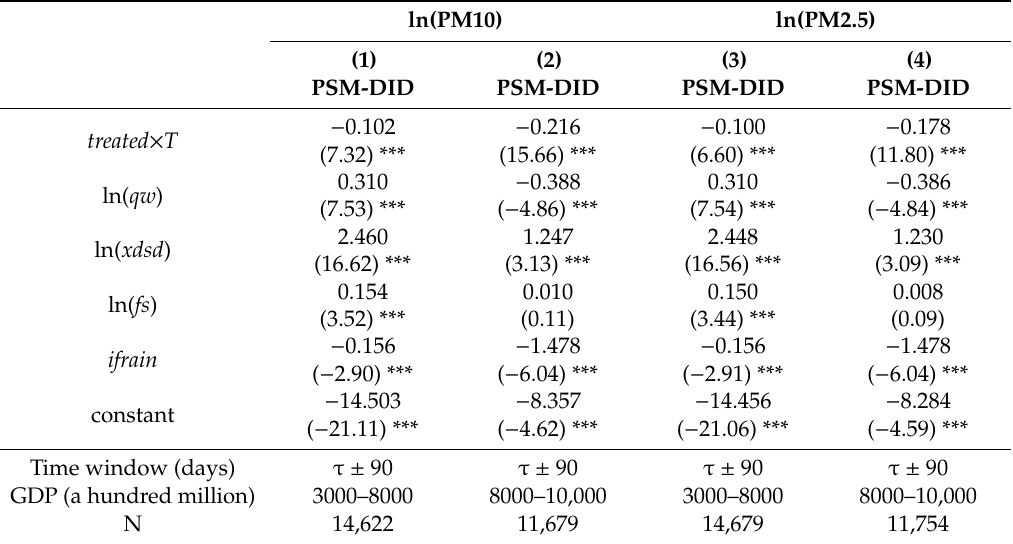
Table 8. PSM-DID estimates with di ff erent levels of GDP.